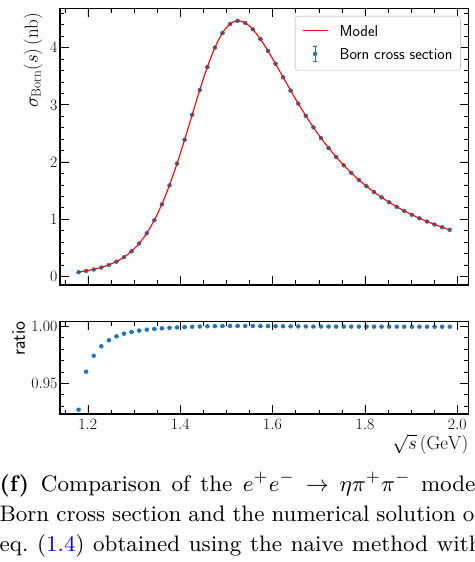
(e) Comparison of the e + e − → ηπ + π − model Born cross section and the numerical solution of eq. (1.4) obtained using the naive method with the generated visible cross section. Figure 5. Results of the numerical experiment with the e + e − → ηπ + π − cross